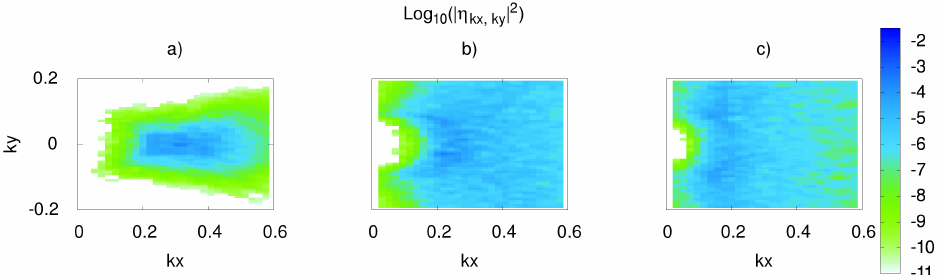
Figure 5. The evolution of spectrum | η ( k x , k y , t ) | 2 in time in logarithmic scale. The color shows the squared amplitude of the harmonic. Panel ( a ) corresponds to the almost initial surface at time t ≈ 2 min. Panel ( b ) corresponds to the surface at time t ≈ 1 h, and Panel ( c ) corresponds to the surface at time t ≈ 26 h.